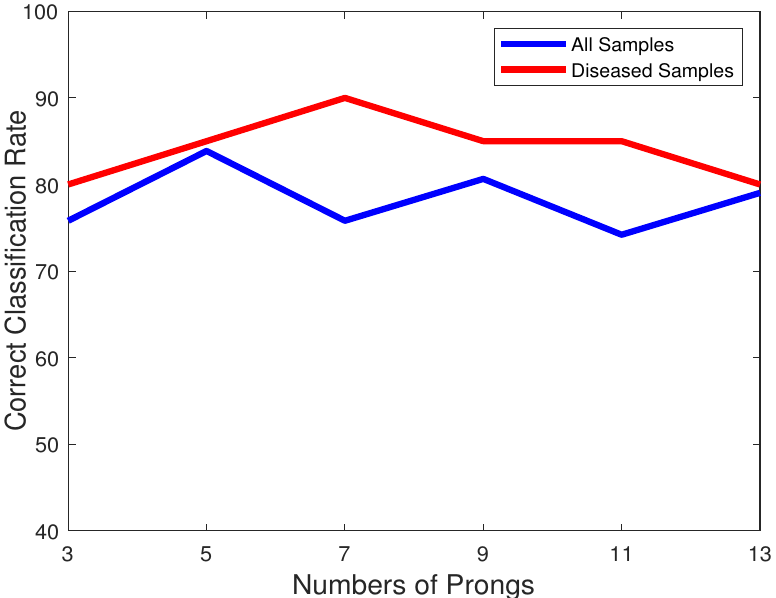
Figure 5. Plot of classification accuracies of all samples (blue) and only diseased samples (red) vs. the number of